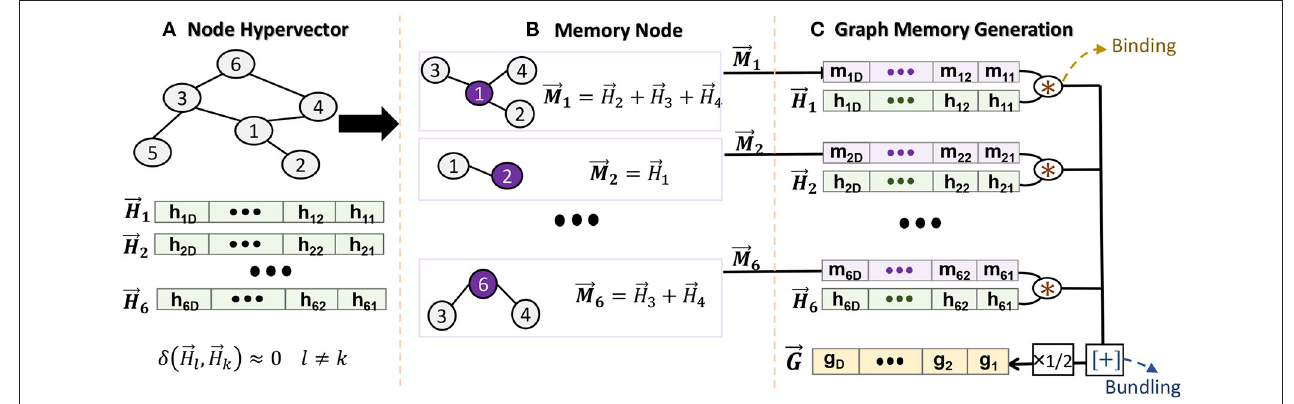
FIGURE 3 | Node memory encoding in GrapHD for weighted graph: (A) node hypervector generation, (B) creating weight hypervectors, and (C) node memory generation.